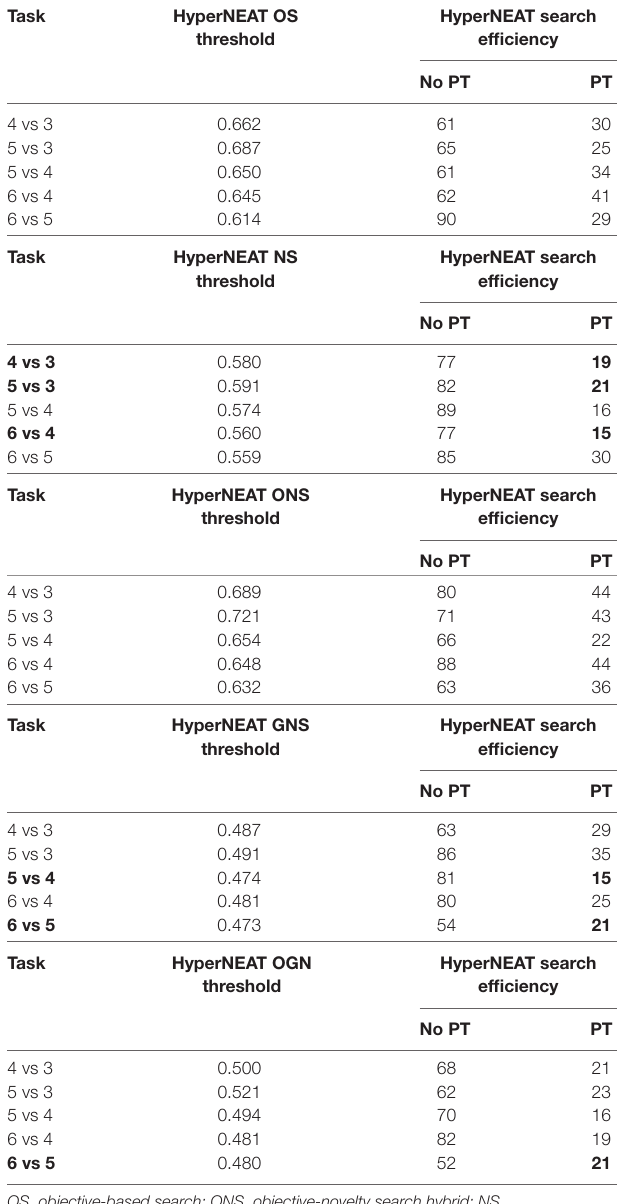
TaBle 5 | HyperNEAT variant efficiency comparison with policy transfer (PT) and no policy transfer (No PT). Task hyperneaT Os